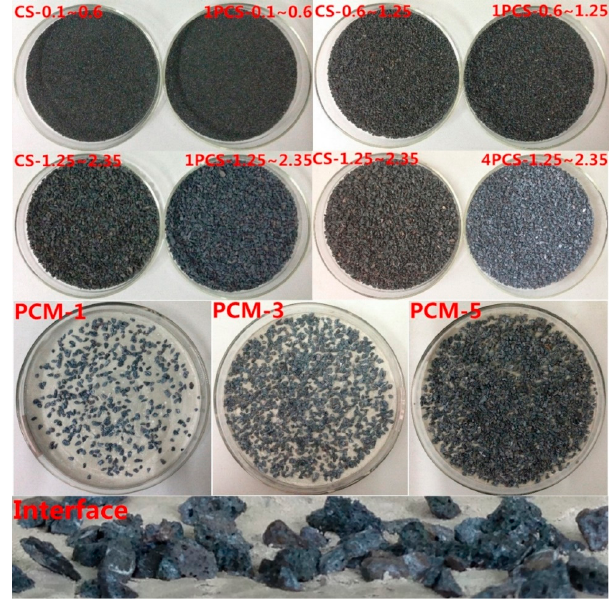
Figure 2. Surface morphology of photocatalytic ceramsite sand and photocatalytic cement materials and the interface of PCS and cement; CS-n and mPCS-n (m was the coating concentration of TiO 2 absolute alcohol dispersion, m = 1~4 g/L, n was the particle size of CS, n = 0.1~0.6, 0.6~1.25, 1.25~2.35 mm); PCM-1, 3, 5 (photocatalytic cement materials with 1, 3, 5 g PCS); PCS: photocatalytic ceramsite sand; CS: ceramsite sand; PCM: Photocatalytic cement